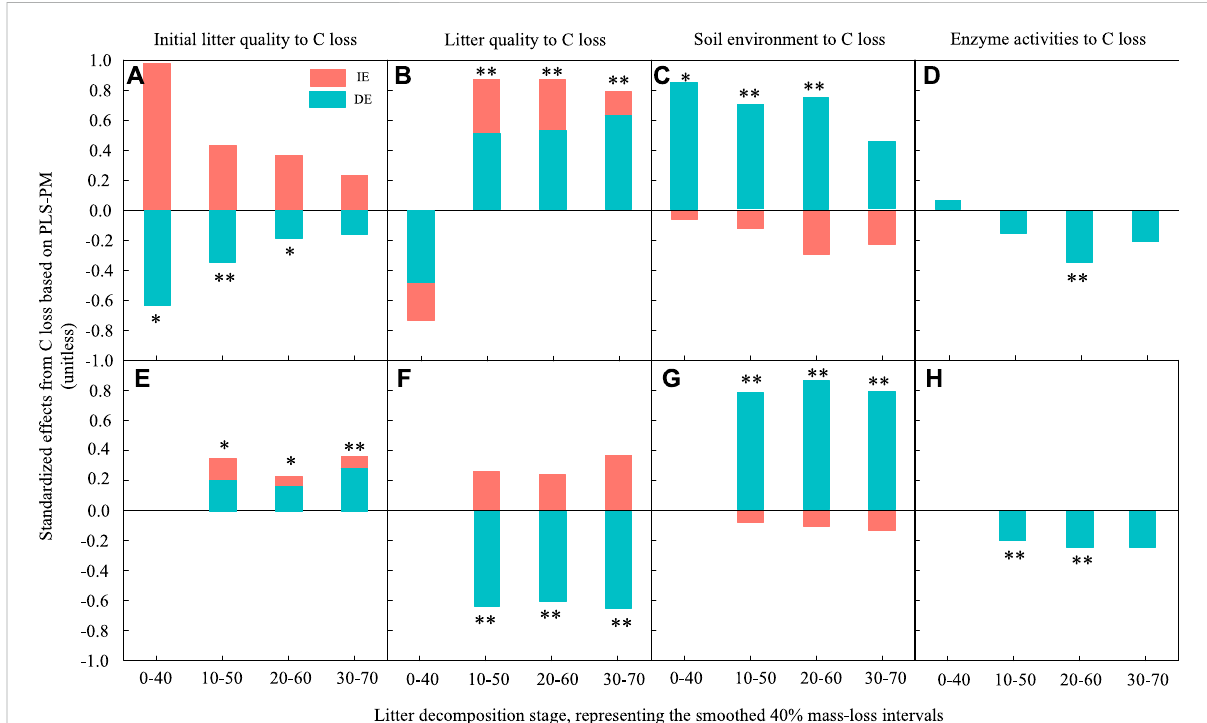
FIGURE 6 Thestandardizeddirectandindirecteffectsderivedfrompartial leastsquares pathmodelling(PLSPM)toassesstheeffectsofinitiallitterquality, litter quality, the soil environment and enzyme activities on leaf and root litter C loss during decomposition. (A) and (E) represent the effect of initial litterqualityonClossforleaf androotlitter, respectively. (B) and (F) representtheeffectoflitterqualityonClossforleafandrootlitters,respectively. (C) and (G) representtheeffectofthesoilenvironmentonClossforleafandrootlitters,respectively. (D) and (H) representtheeffectofenzyme activities on C loss for leaf and root litters, respectively. DE, standardized direct effect; IE, standardized indirect effect. ** p < 0.01, * p <